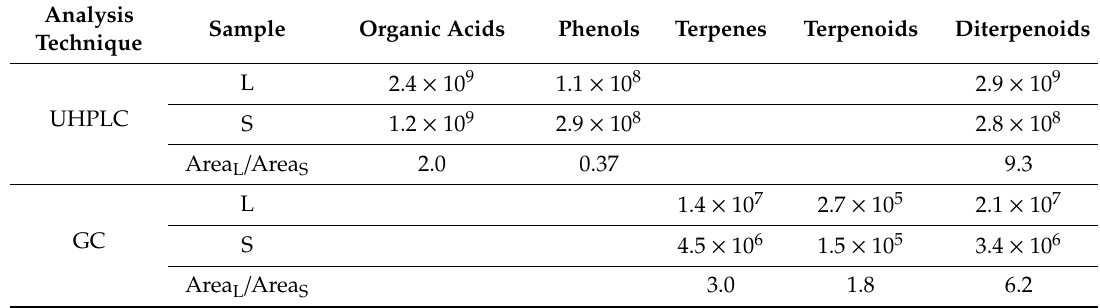
Table 3. Sum of GC-MS peak areas for major classes of constituents in ethanolic extracts of leaves collected in trees exposed to solar light (L) and trees facing north (S) and peak area